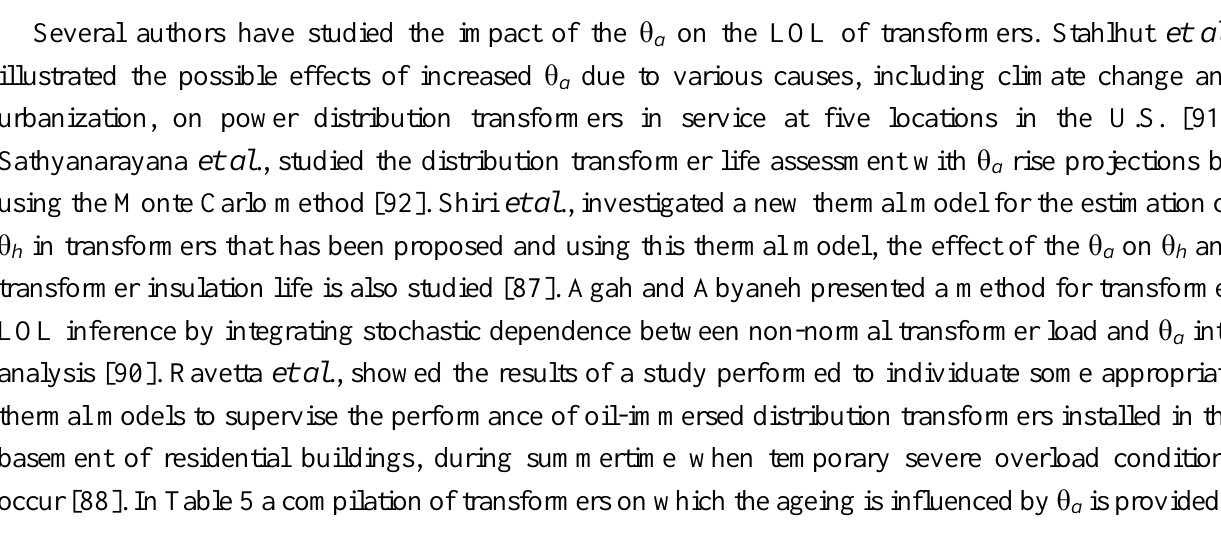
for natural cooled a